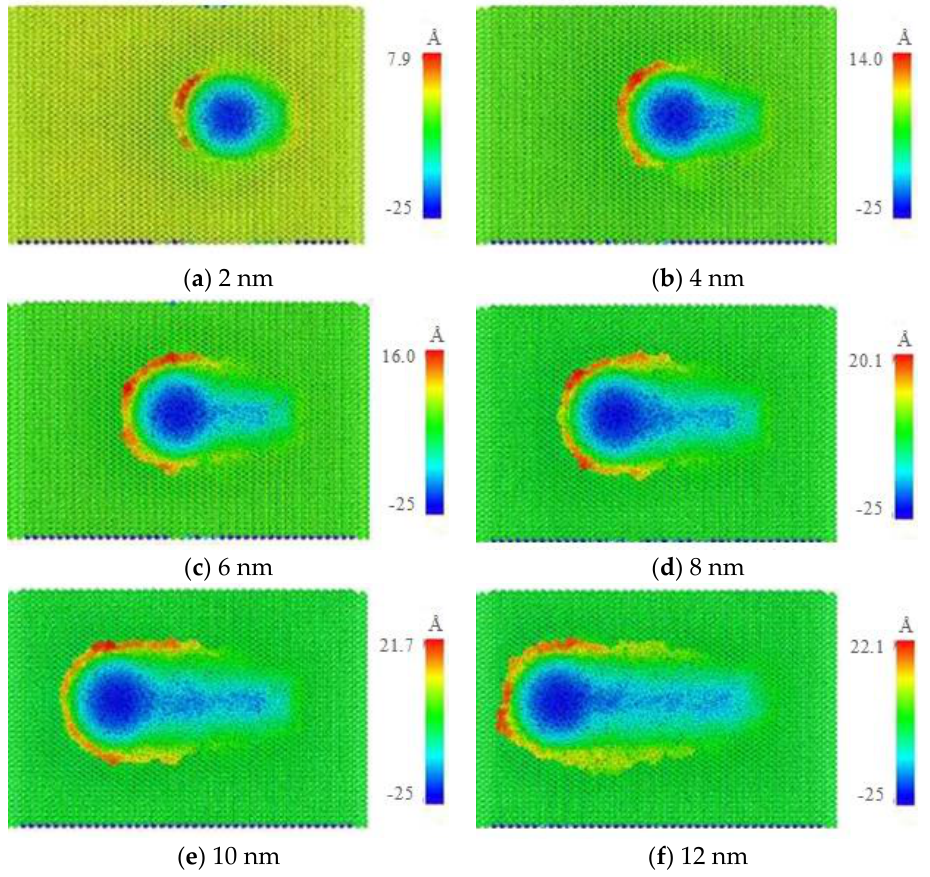
Figure 3. Scratch damage with different scratch lengths.